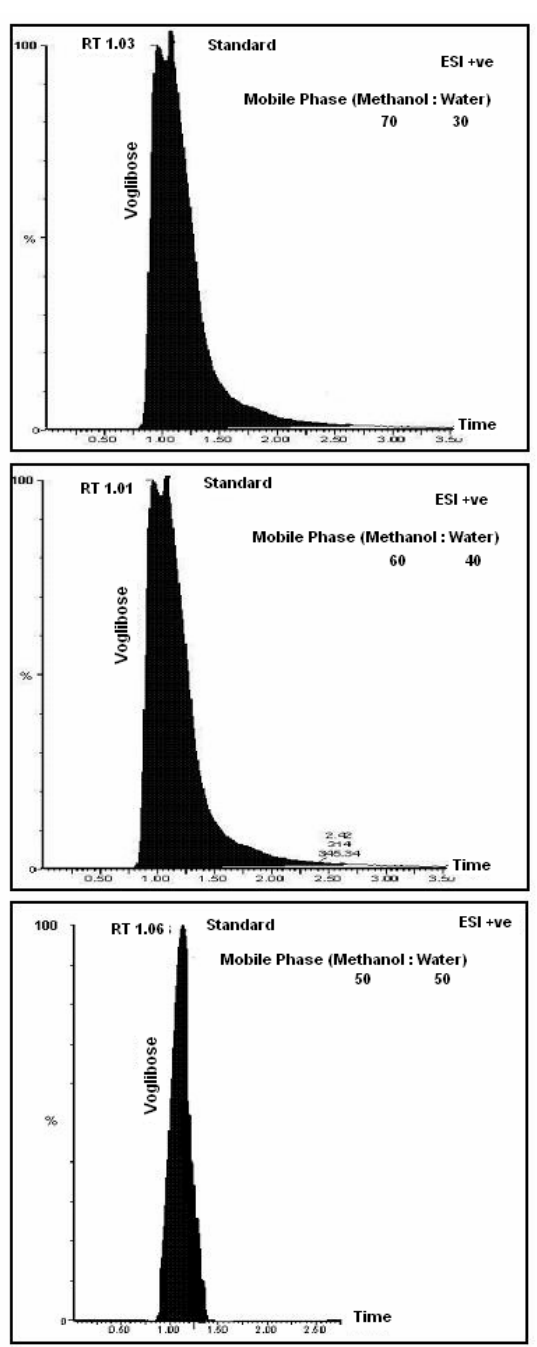
Figure 5. Optimization of mobile phase for determination of voglibose by LC-MS/MS